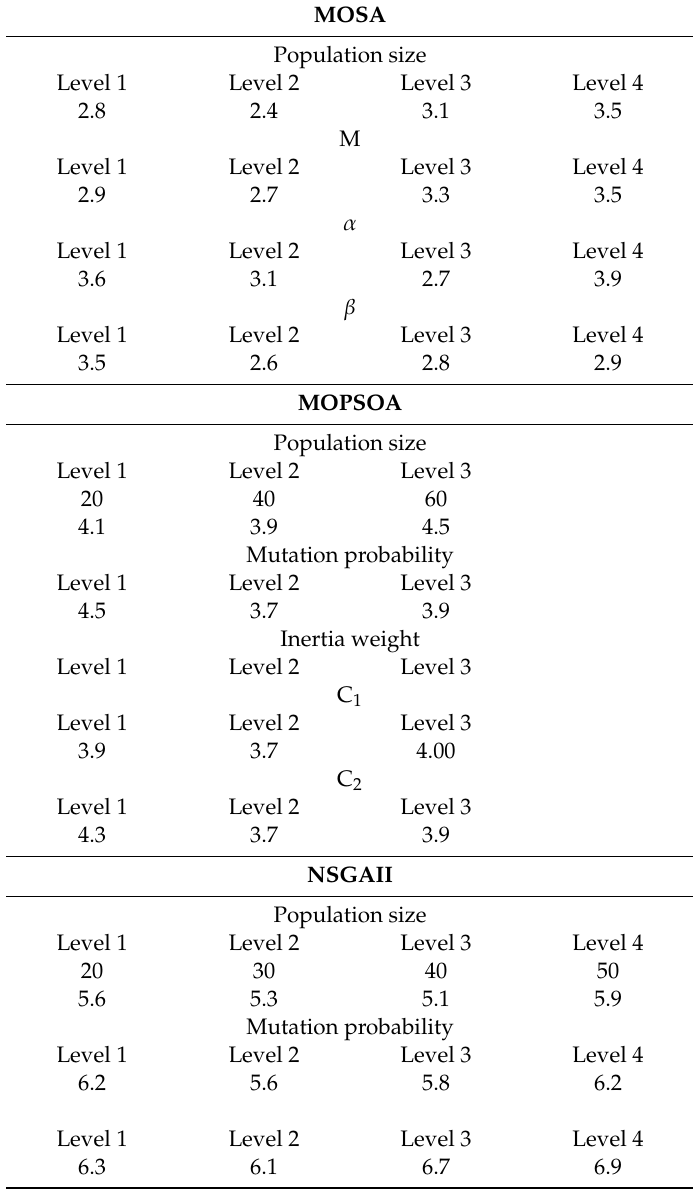
Table 4. Computed results based on the computed average of the relative deviation index (CMRDI) for MOSA, MOPSOA, and